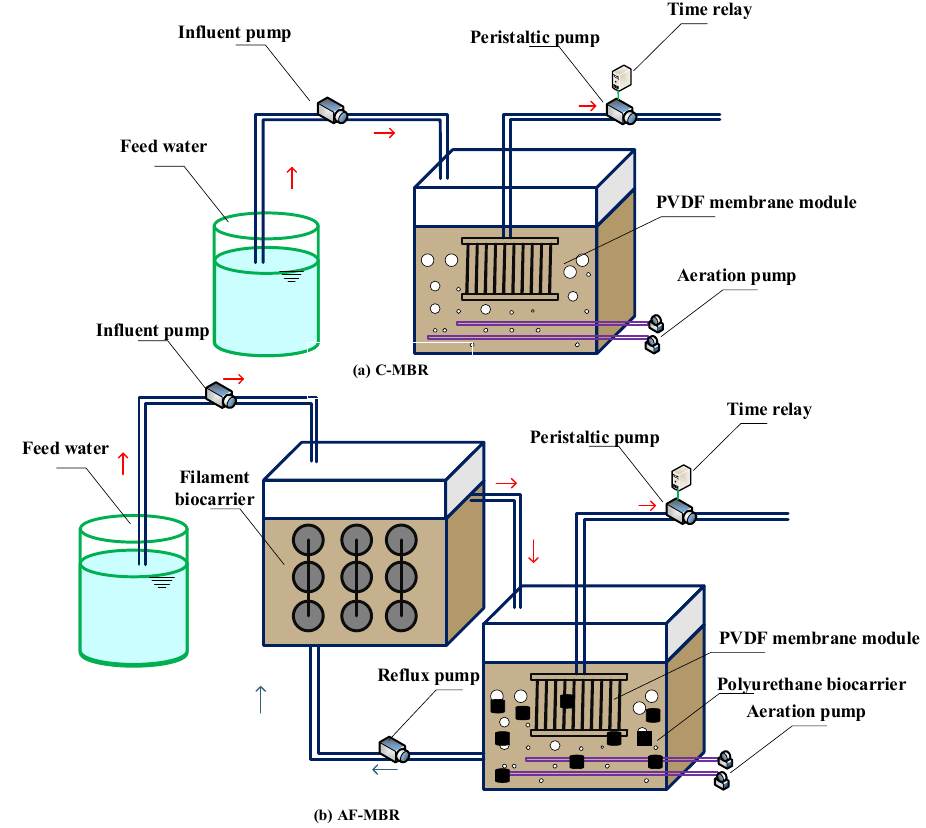
Figure 1. C-MBR ( a ) and AF-MBR ( b ) used in the experiment.